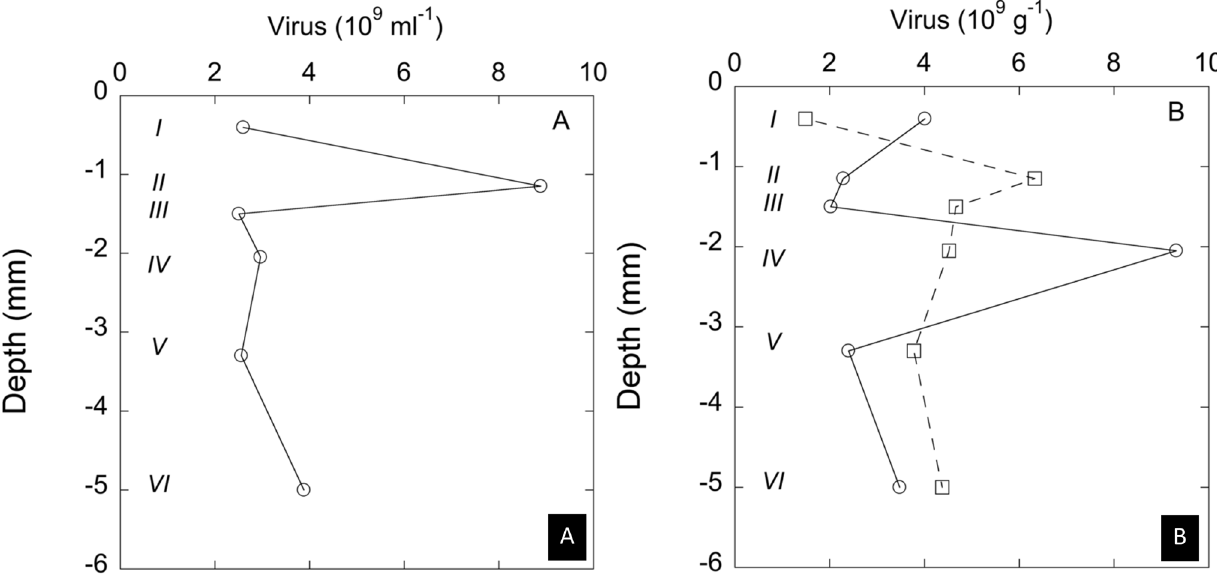
Fig 1. Virus observed in different depth layers (see below) and different fractions of the microbial mat dominated by diatoms, Coleofasciculus chthonoplastes , and Chloroflexus -like bacteria (CLB), sampled in March 2007. Left panel (A): Virus counts in the extracted water fraction (pore water and water soaked into the extracellular polymer matrix). Right panel (B): Virus attached to solid organic and mineral matter. (circles = without acidification, squares = after 10 min of acidification, see Methods). Description of the different layers: I: the top layer from 0 to 0.8 ± 0.2 mm depth, comprised dense populations of diatoms of the genera: Frustula , Cymbella , Denticula , Nitzschia and few bundles of C . chthonoplastes and filaments of CLB; II: layer from 0.8 ± 0.2 mm to 1.5 ± 0.2 mm depth that separated very well from the top layer and comprised lesser densities of diatoms with high quantities biogenic high- Mg calcite grains (cf. Fig 3); III: locally a very fine layer was observed at 1.5 ± 0.3 mm depth that was particularly enriched in biogenic high-Mg calcite embedded in an organic matrix; IV: A layer located below the high densities of biogenic calcium carbonate crystals occurred layer B from 1.5 ± 0.3 mm to 2.6 ± 0.3 mm depth which comprising bundles of C . chthonoplastes and filaments of CLB; V: layer from 2.6 ± 0.3 mm to 4 ± 0.3 mm depth corresponded to a transition zone where large amounts of mineral particles sand grains and biogenic calcite occurred intertwined with of C . chthonoplastes and filaments of CLB; VI: layer comprising black coloured sediment ranging from 4 ± 0.3 mm to 6 ± 0.5 mm depth.